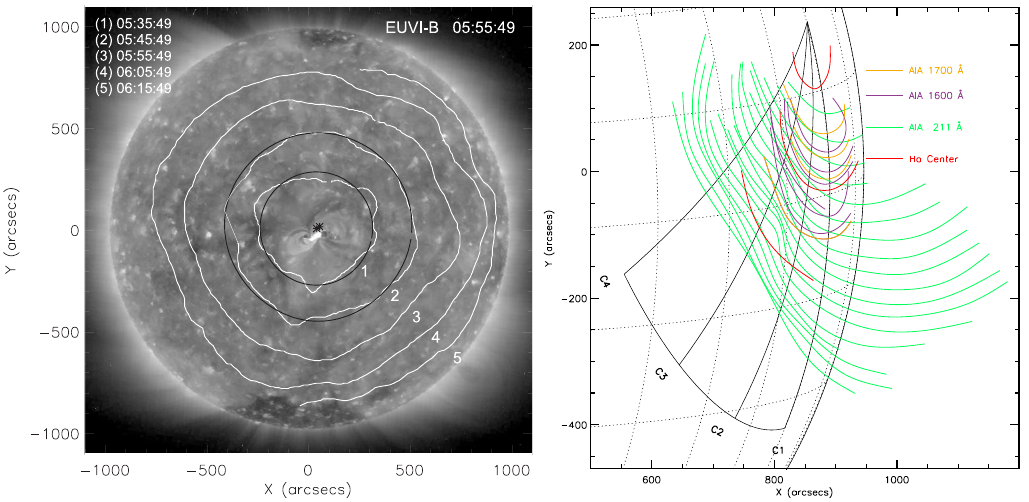
Figure 17: Different angular extents and wavefront shapes. Left : The coronal wave of 2009 Feb 13. Shown is a STEREO/EUVI image at 195 ˚A with overplotted wavefronts derived from 195 ˚A difference images. Note the nearly isotropic propagation of the wave: its angular extent is 360 ∘ , and the wavefronts are well fitted by circles. Right : The large-amplitude wave event of 2011 Aug 9, which was associated with a Moreton wave. Plotted are wavefronts observed at low atmospheric layers (H α , AIA 1600 and 1700 ˚A) and in the corona (AIA 211 ˚A). As is characteristic of Moreton wave events, the angular extent of the wavefronts is confined to a more narrow sector. Images reproduced with permission from [left] Kienreich et al. (2009) and [right] Shen and Liu (2012b), copyright by